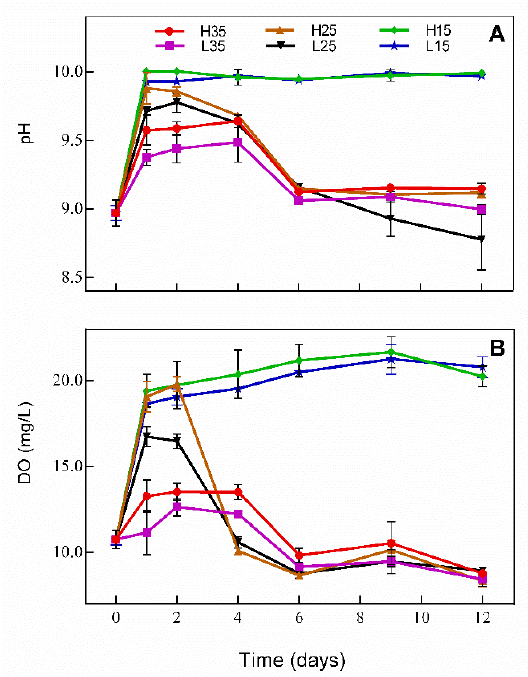
Figure 1. Changes in ( A ) DO and ( B ) pH in water in di ff erent treatments during the experiment.